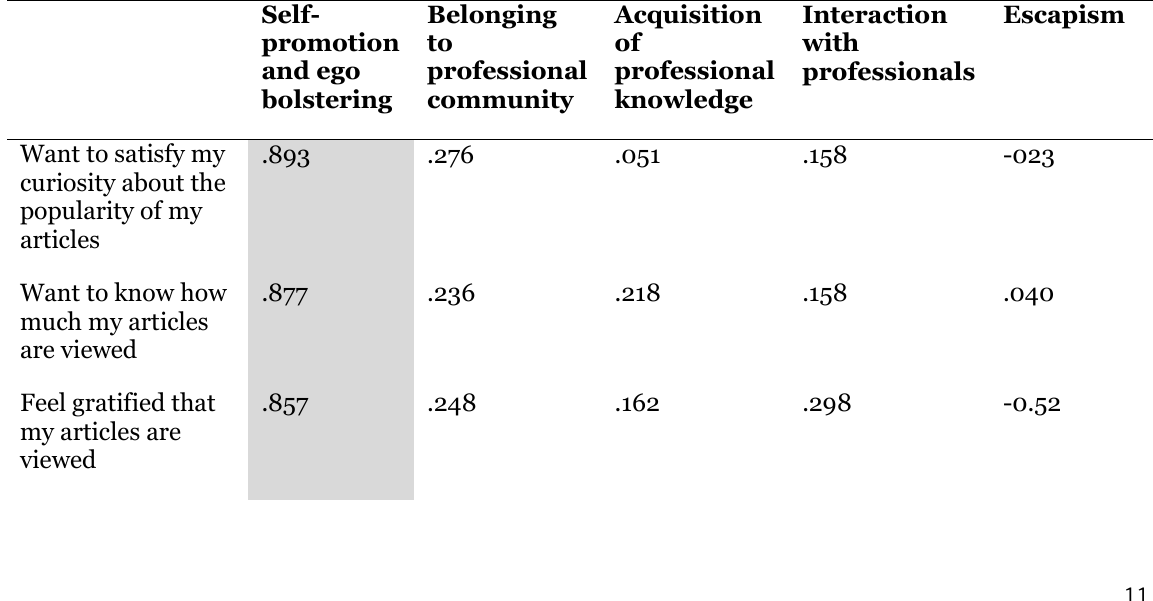
Factor Analysis - Motives for Use of Academic Networks Self-